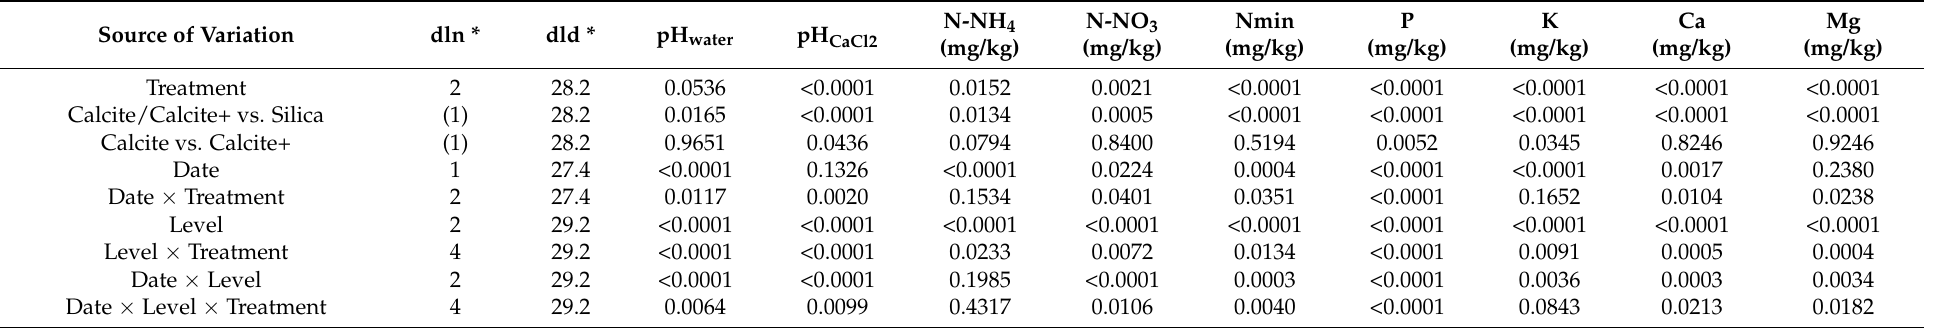
Table 1. Observed probabilities of fixed effects associated with the analysis of variance of variables related to variations in the pH gradient and substrate fertility depending on the covering material (Silica, Calcite and Calcite+) and the level of substrate plug (top, center and bottom) during the germination